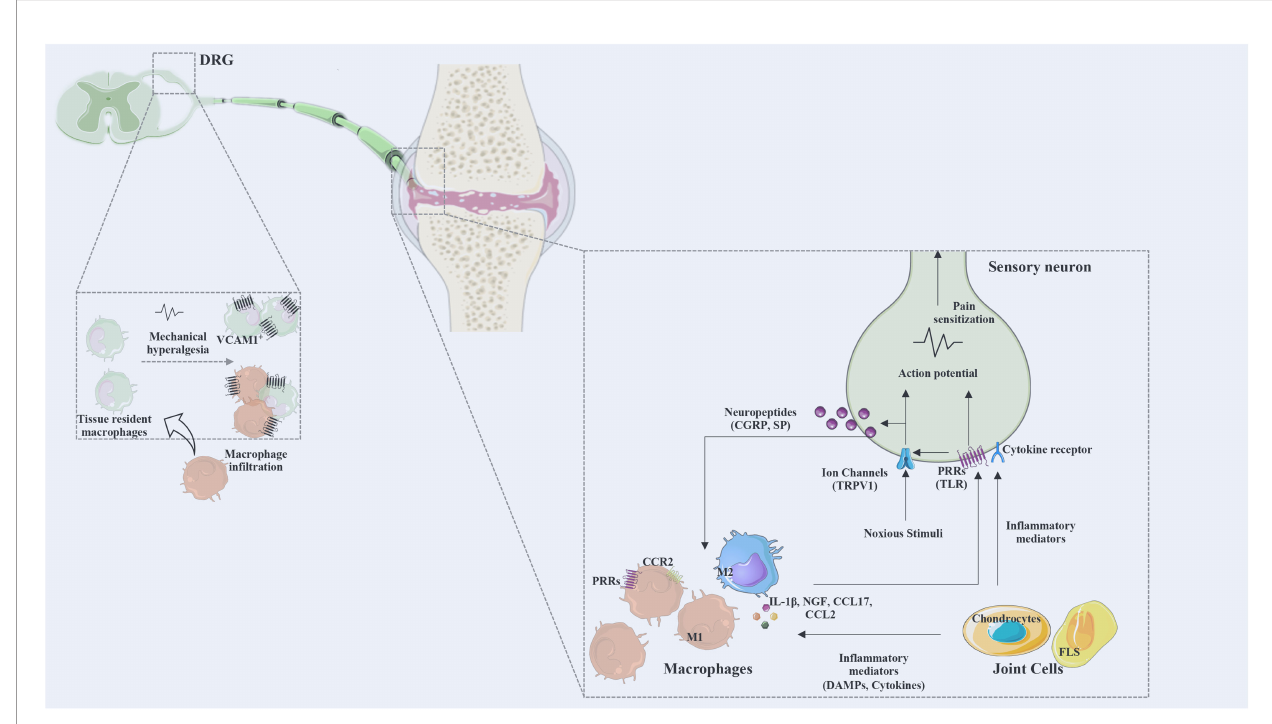
FIGURE 3 | The interaction between macrophages and sensory neurons. Macrophages and joint cells release mediators (cytokines, chemokines, DAMPs, lipid mediators, growth factors) and noxious stimuli that act on ion channels and various receptors for these mediators. Action potentials are transduced via the dorsal root ganglia (DRG) to the spinal cord and transmitted to the brain to be processed as pain. Activated neurons release neuropeptides affecting immune cells and regulating in fl ammatory responses. DRG in fi ltration by macrophages was identi fi ed as a mechanism of pain. M1, classically activated macrophages; M2, alternatively activated macrophages; CGRP, calcitonin gene-related peptide; SP, substance P; PRRs, pattern recognition receptors; TRPV1, transient receptor potential cation channel V member 1; Na 1.7, voltage-gated sodium; TLR, Toll-like receptor; NGF, nerve growth factor; VCAM, vascular cell adhesion molecule; CX3CR, fractalkine receptor; DRG, dorsal root ganglia; CCR, chemokine receptor; CCL, C-C motif chemokine ligand; FLS, fi broblasts-like